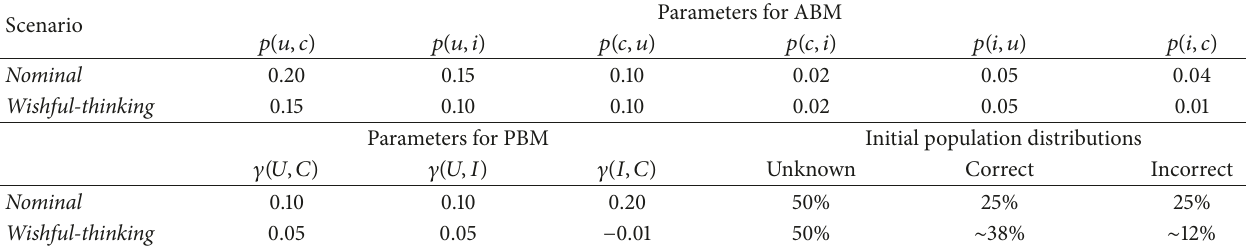
Table 1: Parameters and population settings for nominal and wishful-thinking